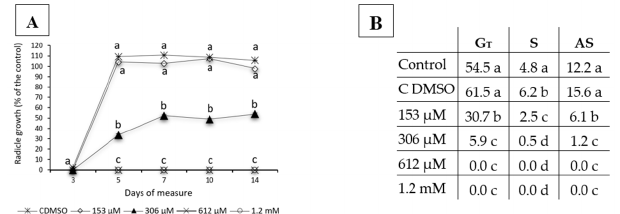
Figure 2. ( A ) Radicle growth and ( B ) germination indices (G T , S and AS) for Erigeron bonariensis seeds after treatment with 0 (control), 0 + DMSO (control with DMSO), 153 µM, 306 µM, 612 µM and 1.2 mM concentrations of norharmane (NOR). Germination and growth were recorded after 3, 5, 7, 10 and 14 days to monitor both processes. Letters indicate statistical di ff erences among treatments for germination ( A ) or radicle growth ( B ) at p < 0.05. One letter for more than one treatment means that all the treatments have the same